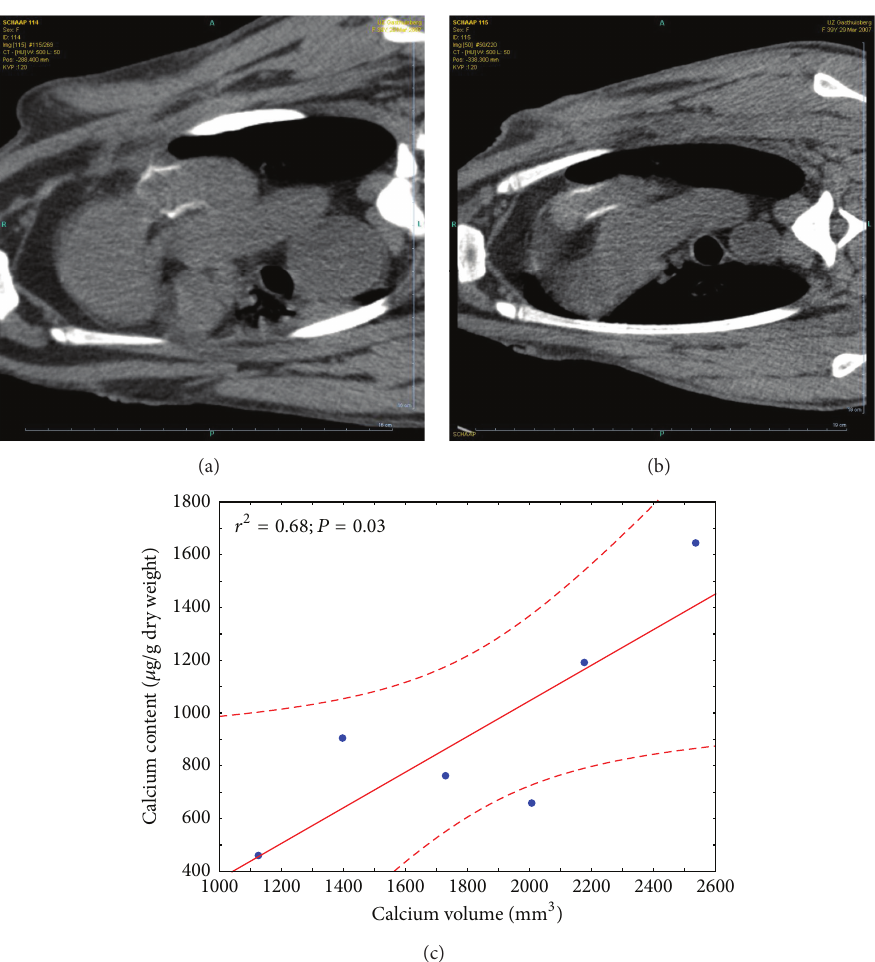
Figure 1: (a) and (b) show two representative examples of CT scans performed at 20 weeks. Clear mineralization of the wall portion is visible. Through further image processing, the region of the implanted valve can be selected. Determination of calcium volume is then performed, with calcium defined as every sample > 100 and < 400 HU. (c) shows the correlation between this CT-based calcium volume determination (in mm 3 ) and the calcium content ( 𝜇 g/g dry weight) as measured with the spectrophotometer.